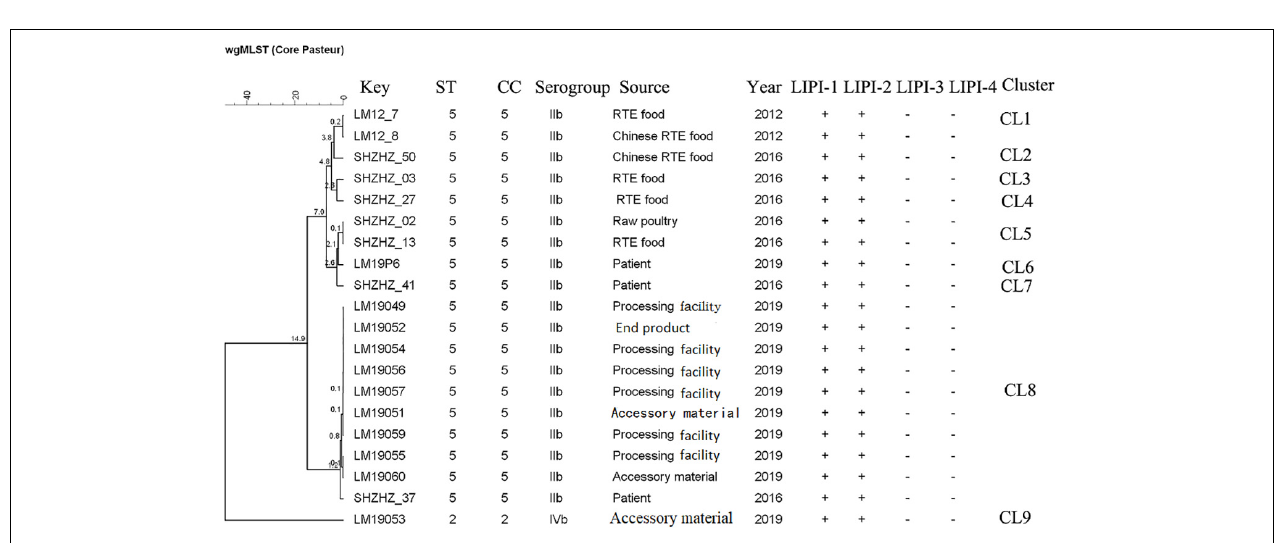
FIGURE 1 | Relationships of the L. monocytogenes isolates based on PFGE. The 12 L. monocytogenes isolates were analyzed by PFGE using Asc I.